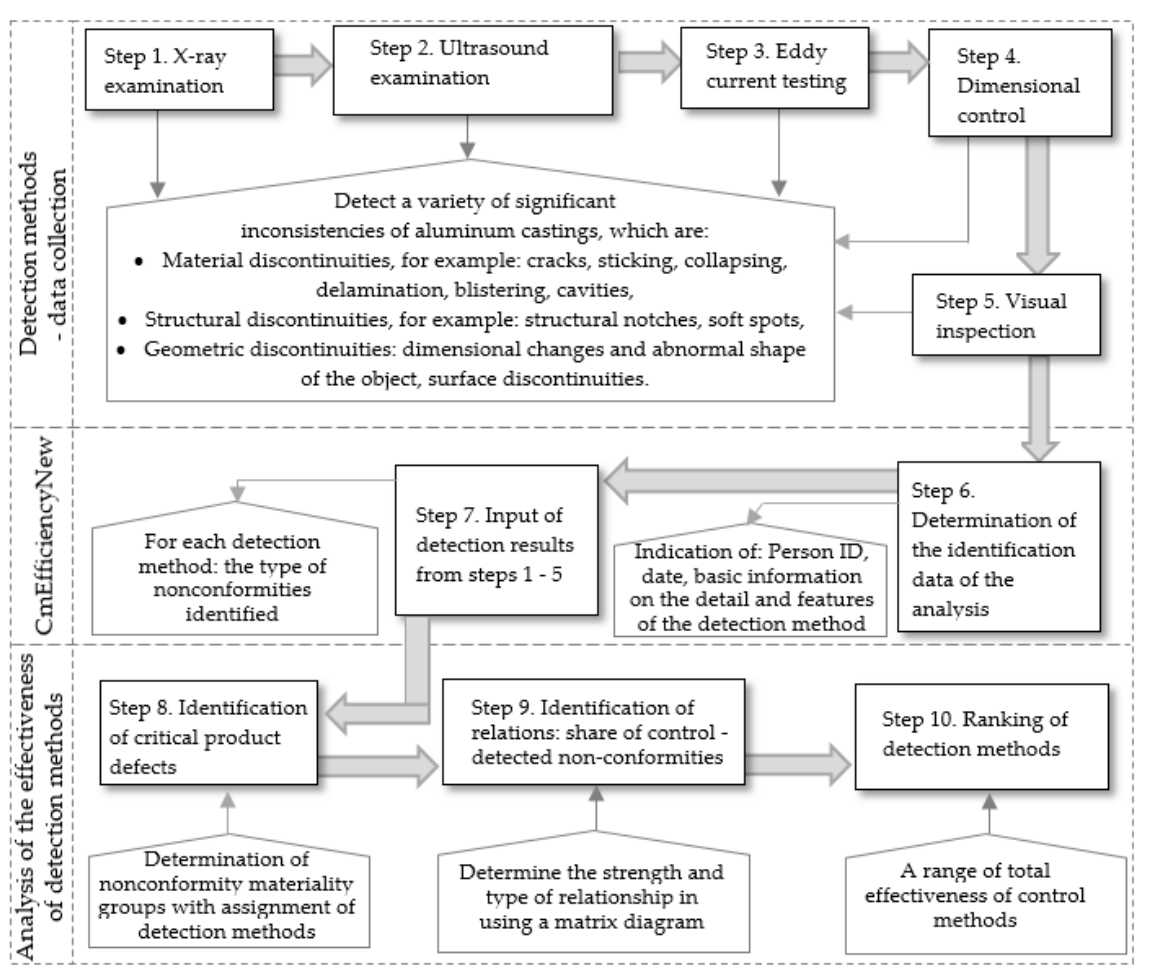
Figure 1. Idea diagram of the control methods analysis model.